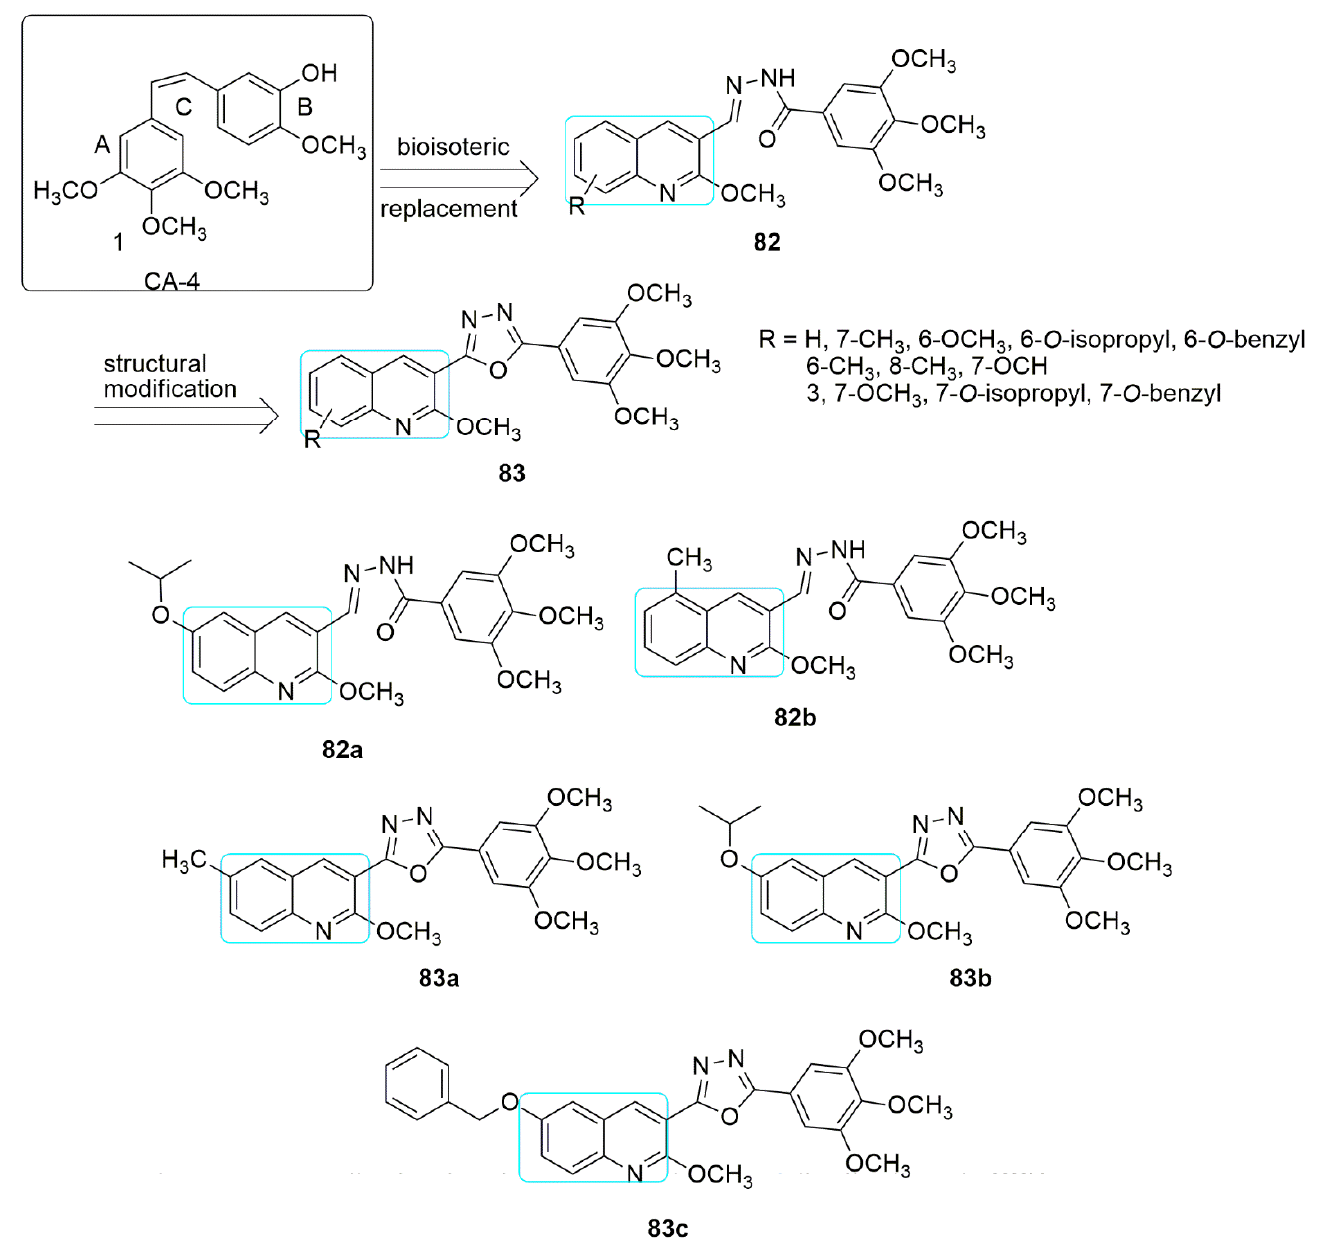
Figure 24. Chemical structures of quinoline conjugates of combretastatin A-4.